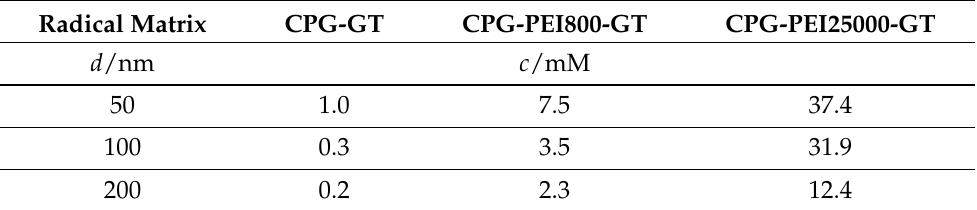
Table 1. Concentrations c of immobilized GT on CPGs with pore size d of 50, 100 and 200 nm from EPR measurements. Radical matrices were synthesized without linker (CPG-GT), with